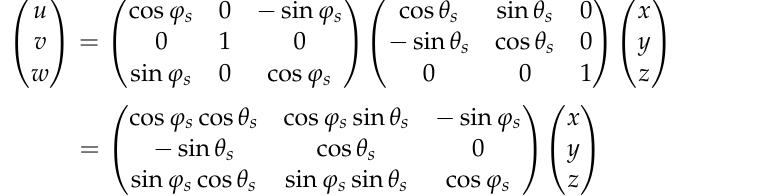
Figure 11. Original color image of silicon dioxide. Table 2. Table of actual melting rates of silicon dioxide by volume.